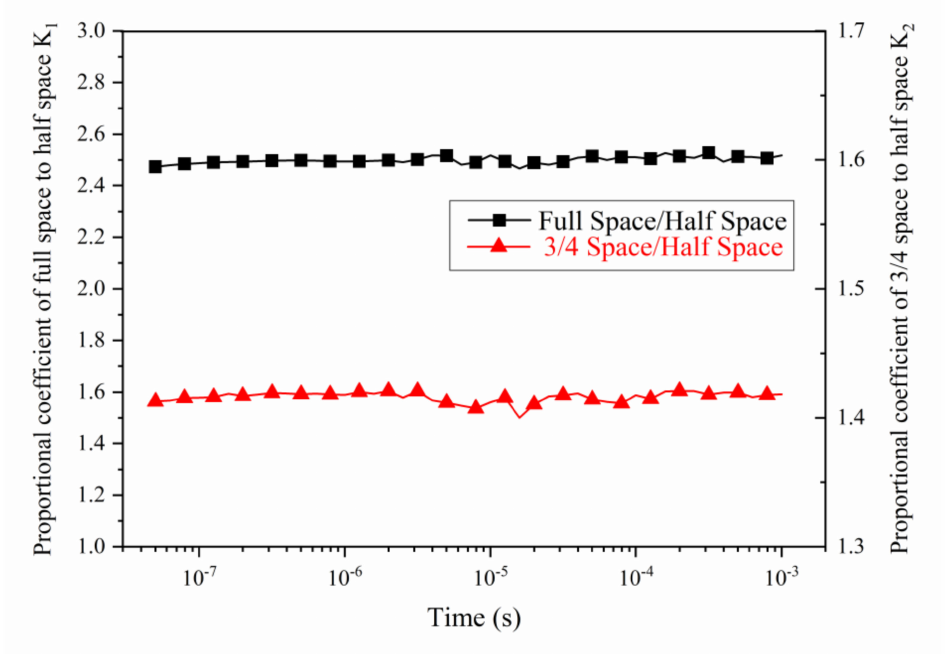
Figure 6. Proportional coefficients of different spaces in the uniform